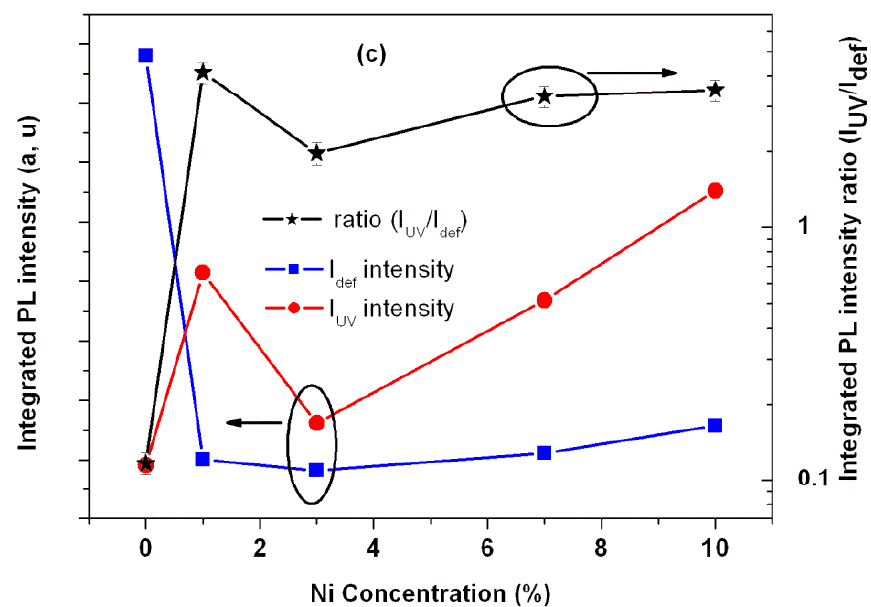
Figure 6. ( a ) Room temperature PL spectra of ZnNiO nanoparticles. ( b ) PL spectra of 10% ZnNiO along with the Gaussian fit. Luminescence arising from the pure bulk ZnO is shown as a reference. ( c ) Integrated PL intensity of the UV band (I UV ), the wide defect related band (I def ) and relative PL peak intensities ratio R (I UV / I def ) vs Ni concentration.